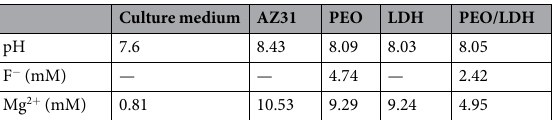
Culture medium AZ31